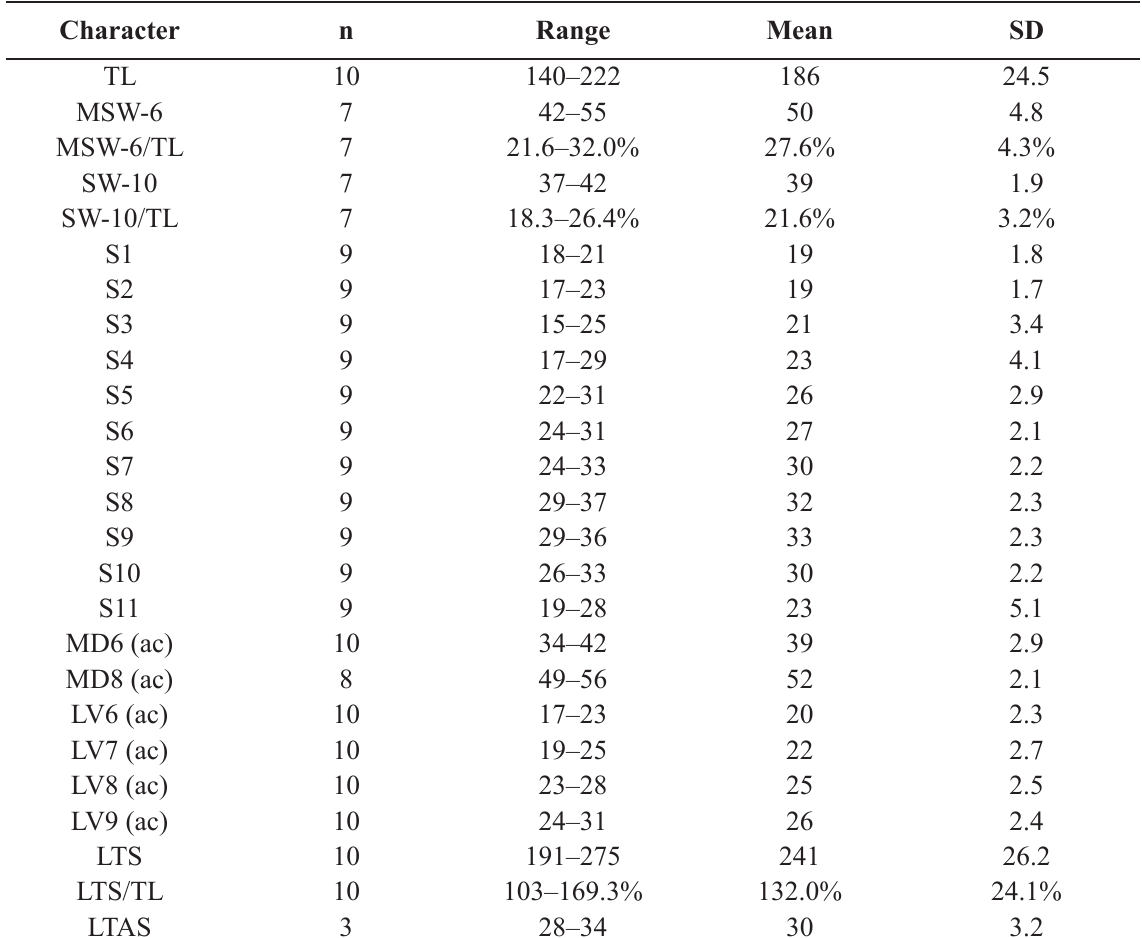
Table 10. Measurements from light microscopy of Echinoderes gandalfi sp. nov . (in µm) from the Hikurangi Margin, including number of measured specimens (n) and standard deviation